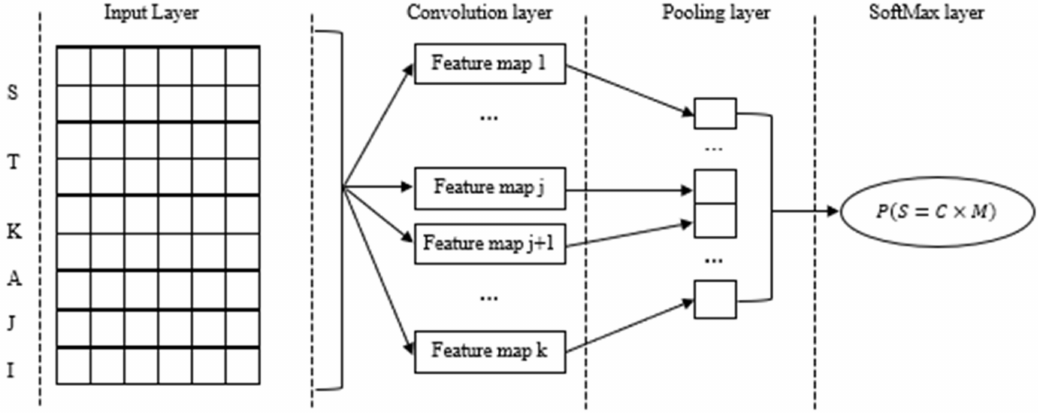
Figure 5. Structure of the CNN model.